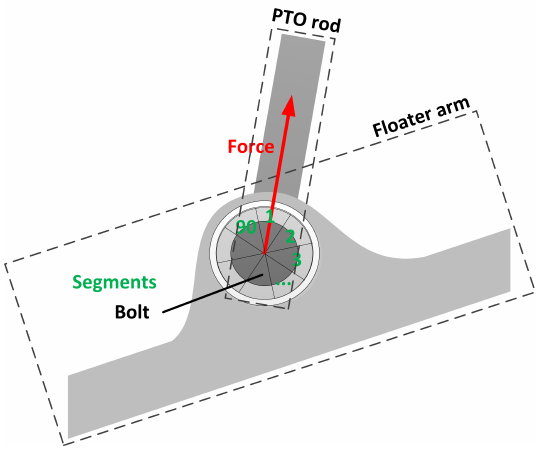
Figure 7. Sketch of the considered plain bearing